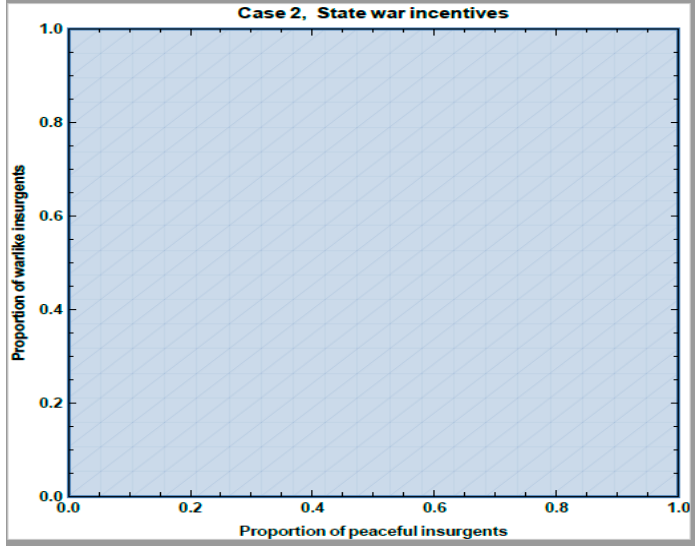
Figure 4. Fitness for state when r = 0.9, δ = 0.1, c = 0.2, and p = 0.5. If we pick a point in the space, say (0.2, 0.4), in Figure 1, that point represents a population of State Actors, 20% of whom are War type, 40% are Peace type, and by default, 40% are Bargain type. The shading represents the proportions of State Actors that make war the fittest strategy for Insurgents. Correspondingly, x w changes along the vertical axis, and x p changes along the horizontal axis of Figure 2. Thus, a point such as (0.2, 0.4) represents a population of Insurgents, 20% of whom are War type, 40% are Peace type, and by default, 40% are Bargain type. The shading shows the proportions of Insurgents that make war the fittest culture for State Actors. Since the entire area is shaded in both figures, we conclude that Bargaining and Peace are not plausible cultures in this scenario. Thus, whatever the initial distribution of cultures in the populations, both the State Actors and the Insurgent population will learn to be warlike under these conditions. War is rationally learned from period to period—conflict becomes